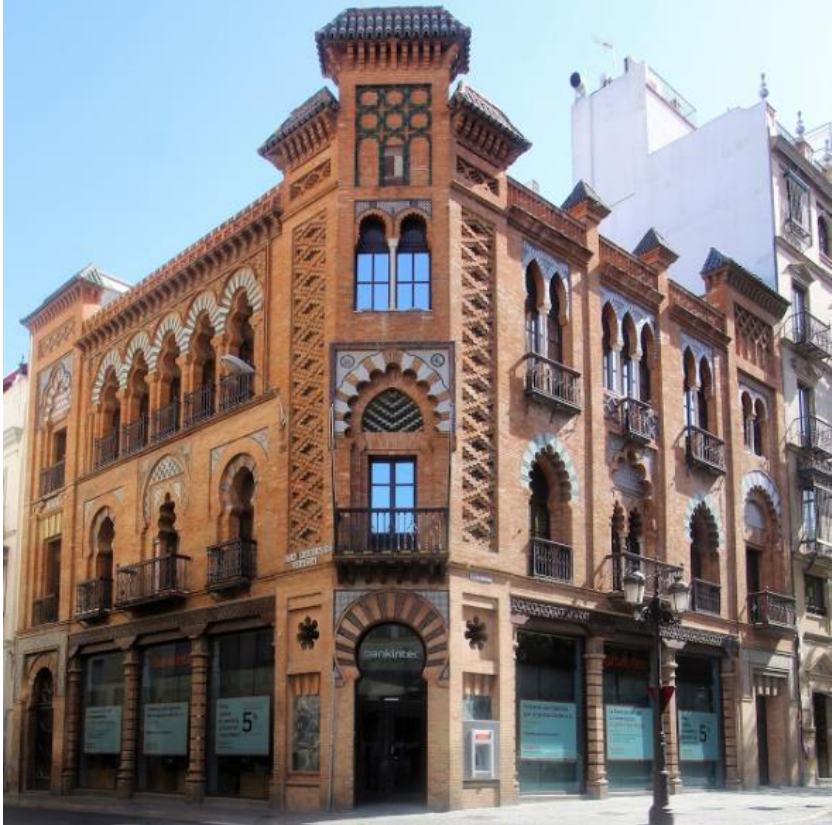
Figure 3. Façade of the house of Manuel Nogueira (1907). Seville. Photo used by permission Conoce Sevilla y sus cosas . © Conoce Sevilla y sus cosas.